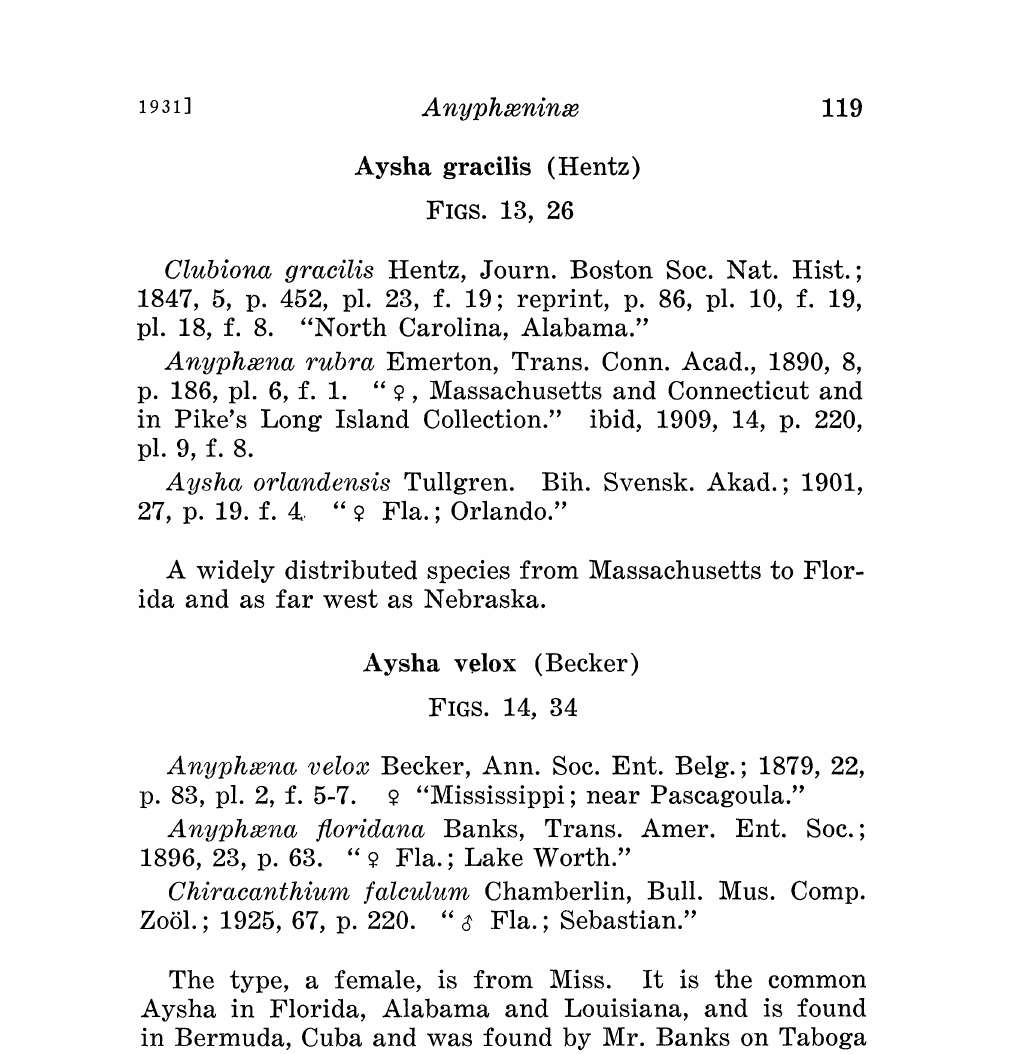
3 8.5 mm. long; ceph. 3